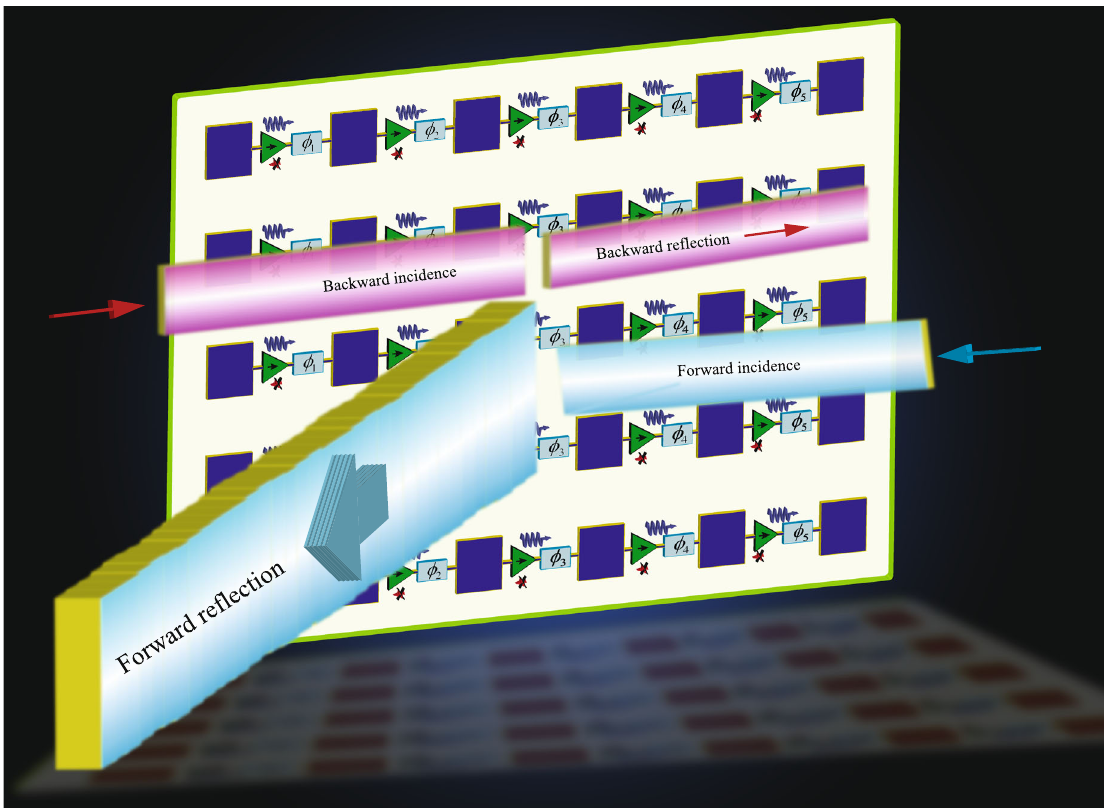
Fig. 1 Schematic of the re fl ective beamsteering metasurface. The metasurface is constituted of cascaded radiator-ampli fi er-phaser chains for simultaneous re fl ection and reception at different angles of reception and re fl ection.